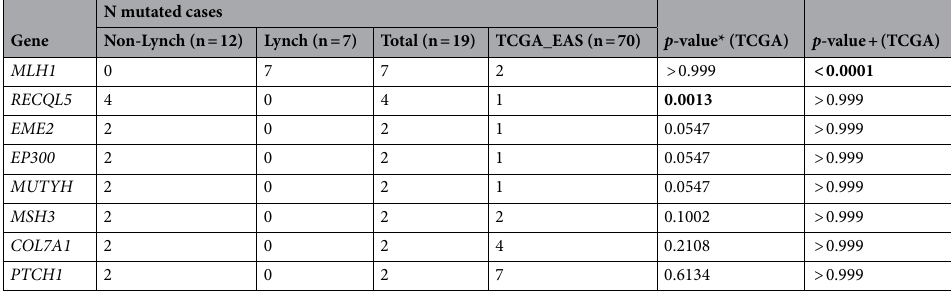
Table 2. Genes affected by Loss of function variants in two or more patients with eoMPC at stomach and colon. p < 0.01 values are in bold. *Fisher’s exact p -value for the frequency of each gene between non-lynch and TCGA. " + "Fisher’s exact p -value for the frequency of each gene between lynch and